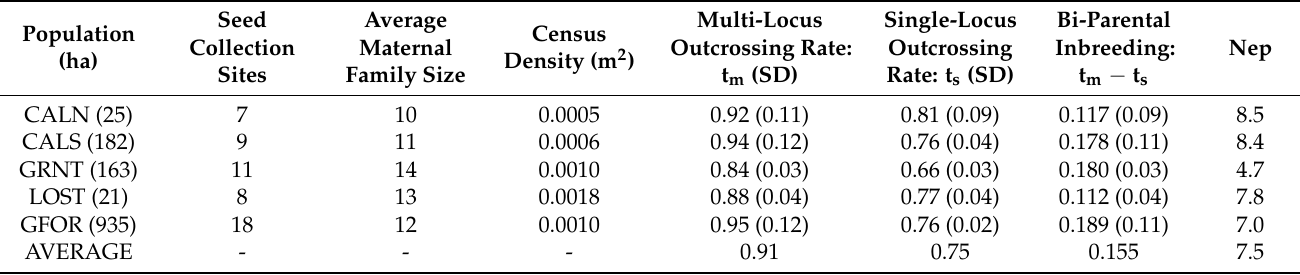
Table 1. Seed collection and mating system parameters for five